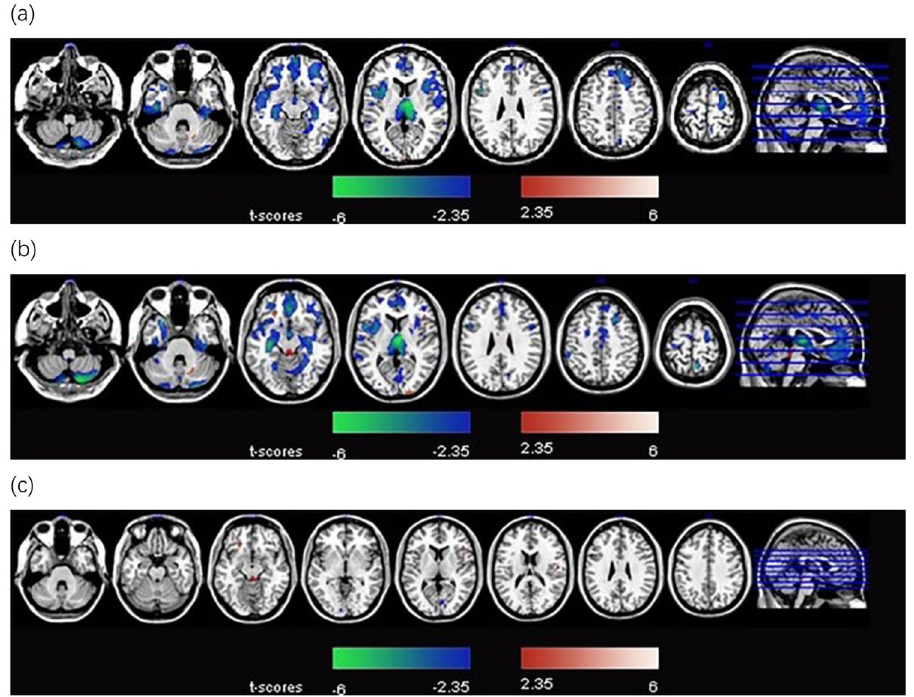
Figure 1. ( a ) Regions showing gray matter volume changes in schizophrenics without tardive dyskinesia (non-TD), as compared with healthy control group. Warm and cool color each represents volume increases (non-TD > control) and decreases (non-TD < control). ( b ) Regions showing gray matter volume changes in schizophrenics with tardive dyskinesia group compared with healthy control group. Warm and cool color each represents volume increases (TD > control) and decreases (TD < control). ( c ) Regions demonstrating gray matter volume changes in schizophrenics with tardive dyskinesia as compared to those without tardive dyskinesia group. Warm and cool color each represents volume increases (TD > non-TD) and decreases (TD < non-TD).